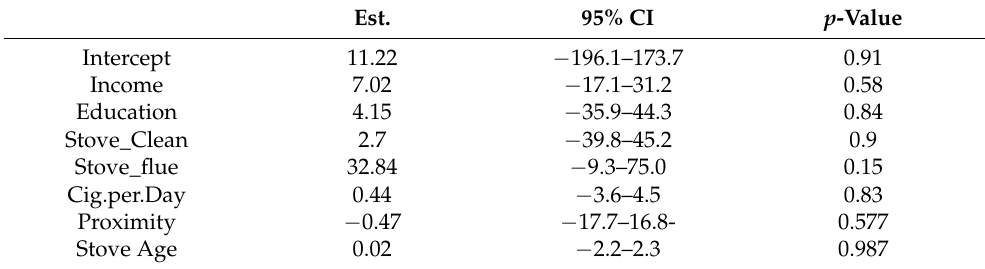
Table 3. Multivariate linear